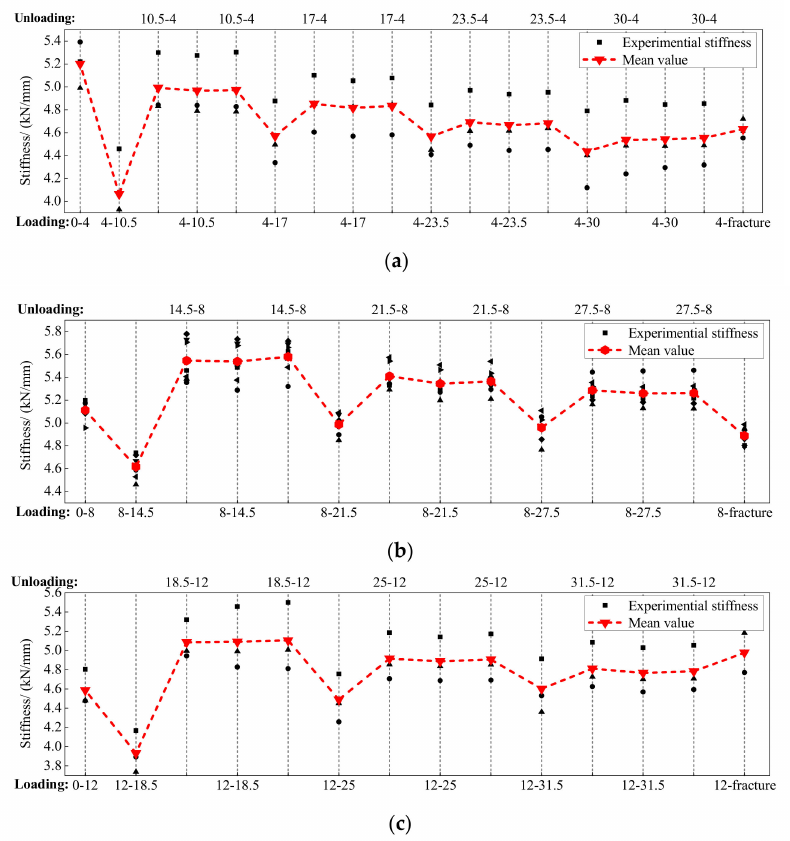
Figure 14. Secant stiffness of the BFRP tendons: ( a ) prestressed displacement of 4 mm; ( b ) prestressed displacement of 8 mm; ( c ) prestressed displacement of 12